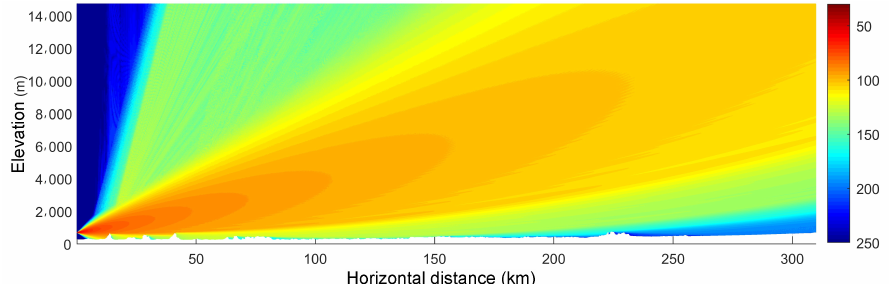
Figure 9. The electric field distribution when the elevation angle of transmitting antenna is θ = 1.394 ◦